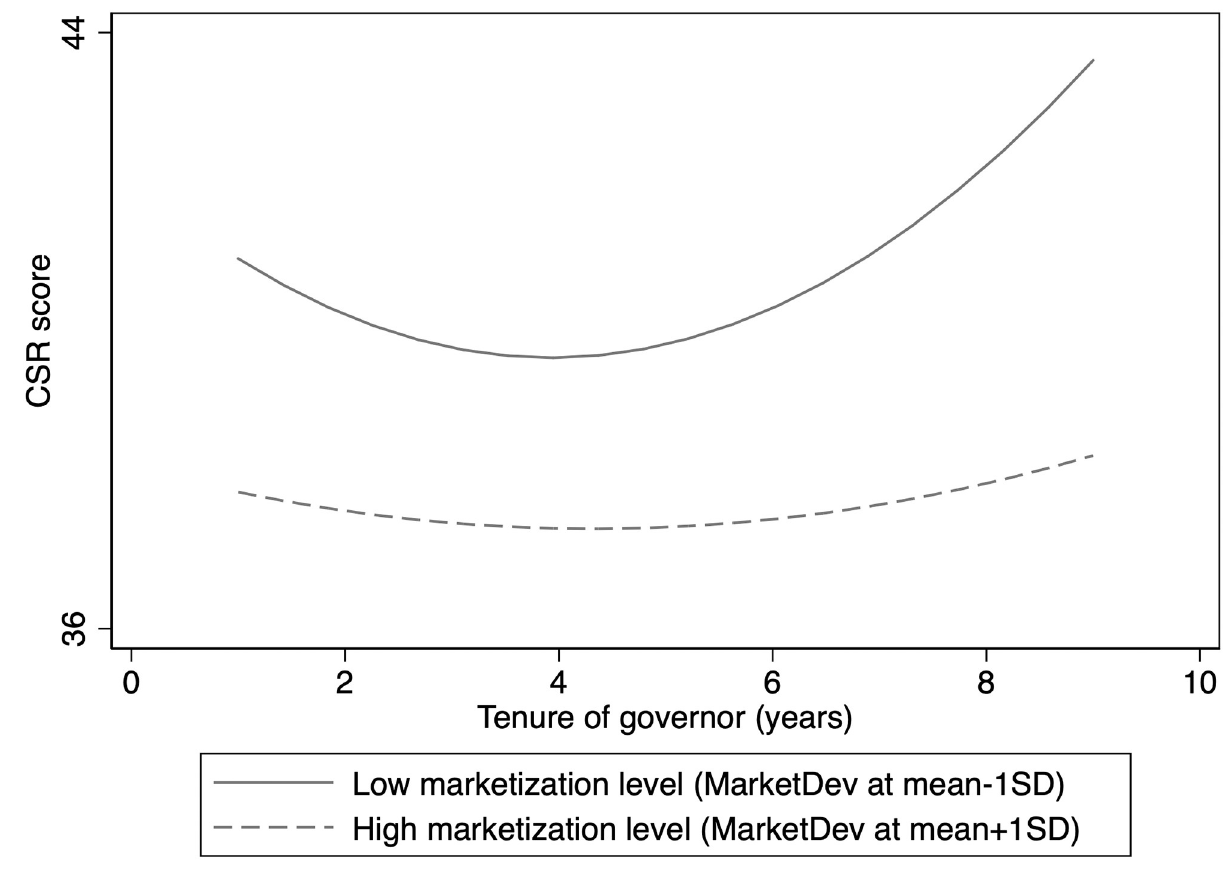
Fig 2. Moderating effect of regional market